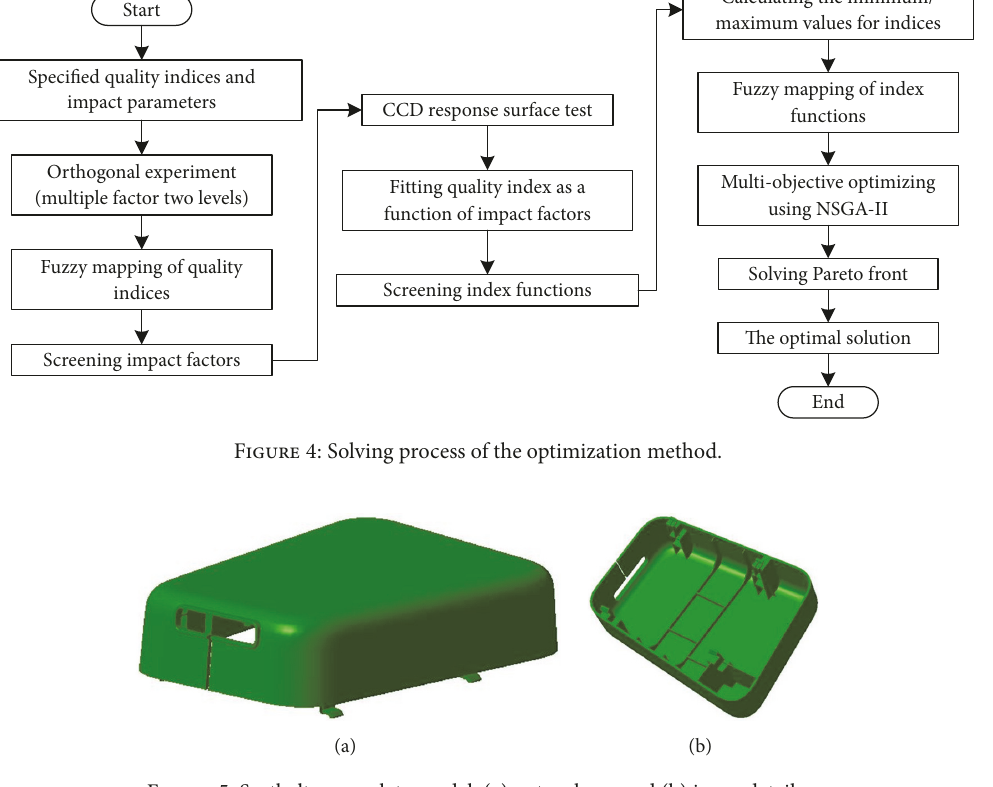
Figure 5: Seatbelt cover plate model: (a) outer shape and (b) inner details.